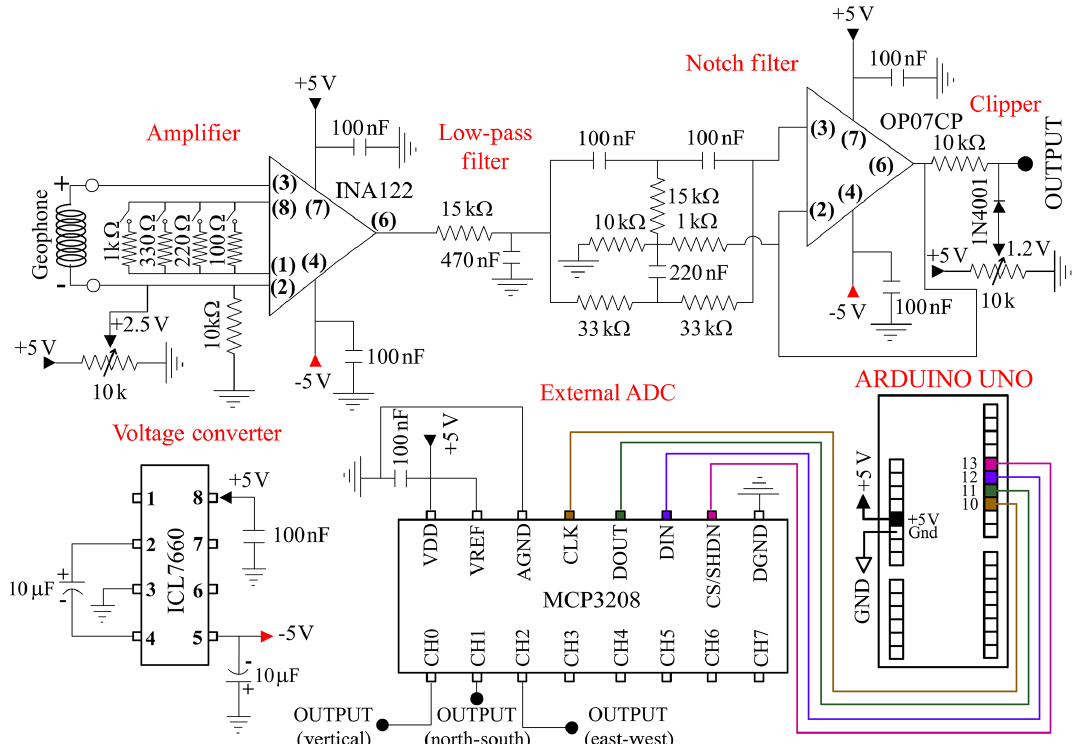
Figure 3. Schematics of external hardware and pin